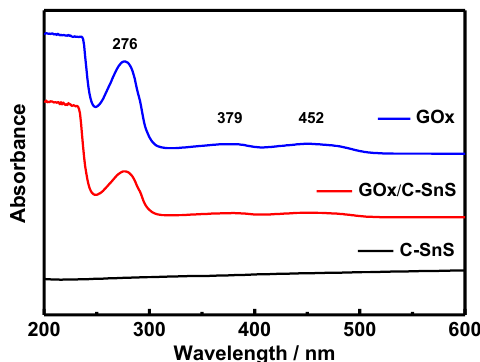
Figure 5. UV–vis spectroscopy of carbon-coated SnS (C-SnS), glucose oxidase (GO x ), and GO x on C-SnS.